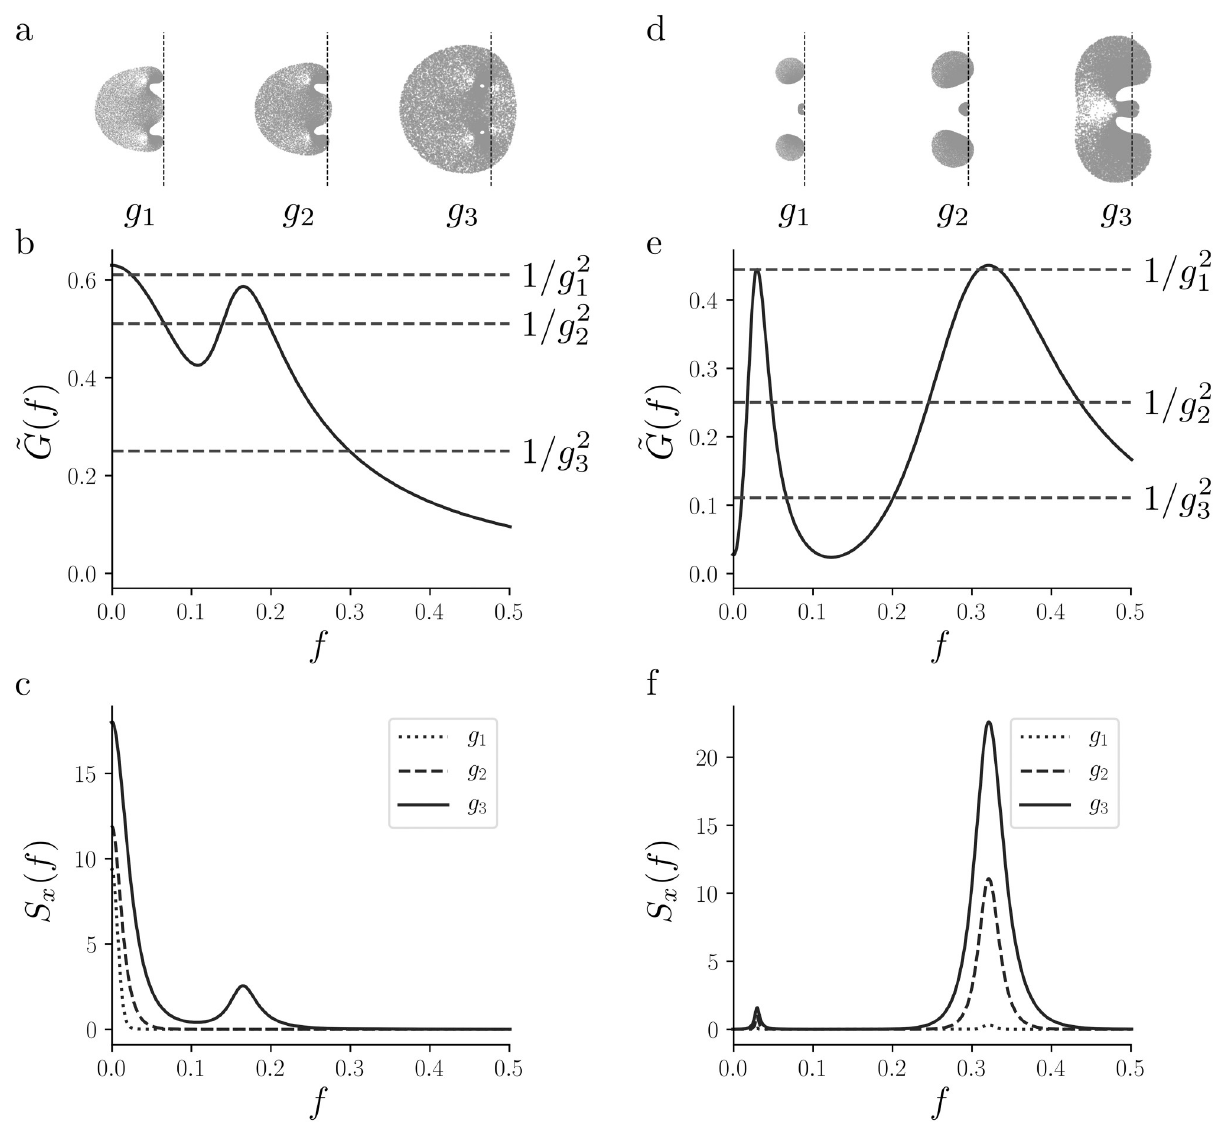
Fig 8. Two examples of multi-dimensional rate models. Parameters defining both models can be found in Table 1. a-b-c: Analysis of a three- dimensional rate model. Eigenvalue spectra ( a ) corresponding to the coupling values g 1 = 1.28, g 2 = 1.4 and g 3 = 2. The dashed line indicates the imaginary axis. In b we plot the linear response function of the single unit ~ G ð f Þ (solid line), and the instability threshold corresponding to the three coupling values g 1 , g 2 and g 3 (dashed lines). In c we plot the solution of the mean field theory obtained with the iterative method for the three values of g , g 1 = 1.5, g 2 = 2 and g 3 = 3. d-e-f: Same as a , b , c ,but for a four-dimensional rate model.